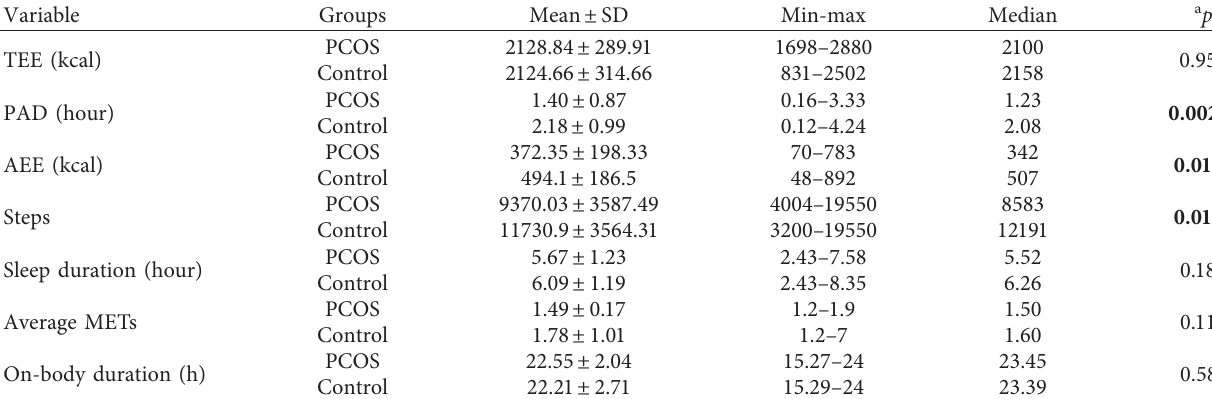
Table 4: Armband metabolic Holter